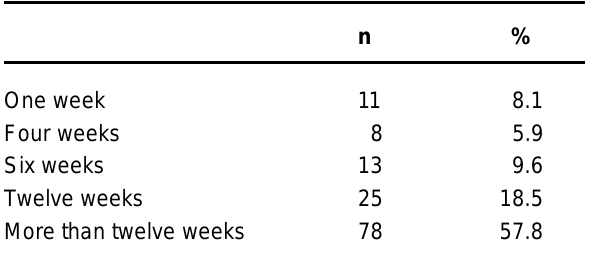
TABLE 4 - Time since the last servicing of the sterilization devices